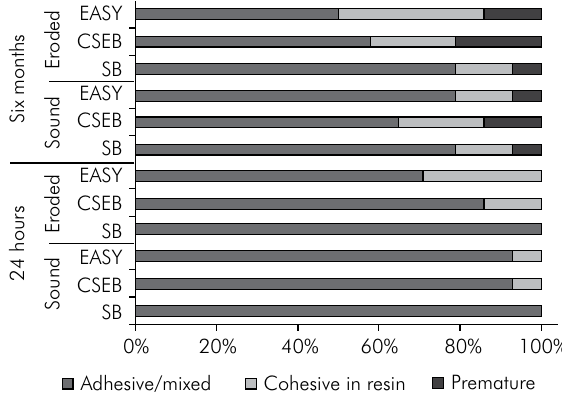
Figure. Failure mode distribution (%).